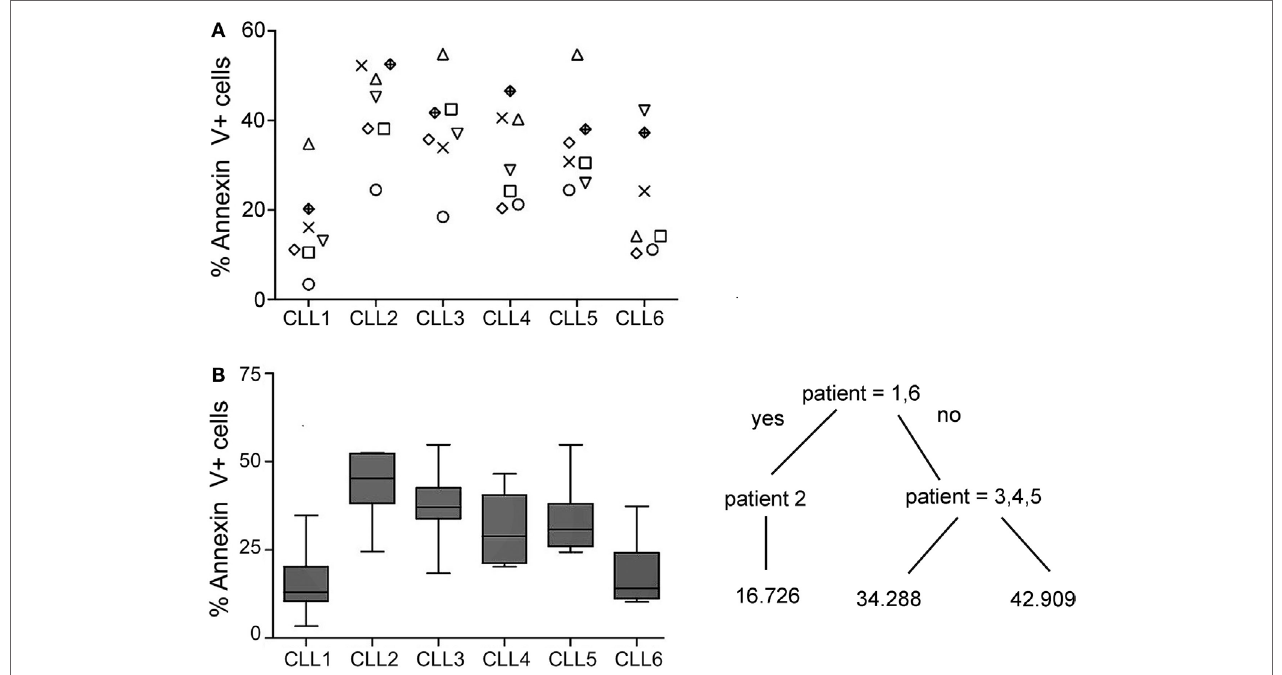
FigUre 2 | analyses of the cytotoxic potential of activated allogeneic nK cells employing six cll patients and seven nK cell donors . Cells from B-CLL patients were incubated with R69-activated NK cells (MACS enriched, > 90% CD56 + CD3 − cells; CTGreen labeled) from seven independent donors for 4 h at 9:1 effector:target ratio in two independent experiments as described in Section “Materials and Methods.” Subsequently, PS traslocation (annexin V DY634) and membrane permeabilization (7AAD uptake) were analyzed by flow cytometry in the cell population negative for CTGreen. (a) The graph represents the % of annexin V positive cells in the 42 combinations (six B-CLL × seven NK). Annexin V + cells represent the % of Annexin V + 7AAD − plus AnnexinV + 7AAD + cells. Each symbol represents a NK cell donor. All NK cell donors were incubated with every B-CLL sample. (B) Cell death (Annexin V + ) in every B-CLL sample was represented in a boxplot where median ± SD is indicated. Statistical analysis was performed employing a regression tree in which patient samples are clustered according to their similarity of sensitivity to NK cell